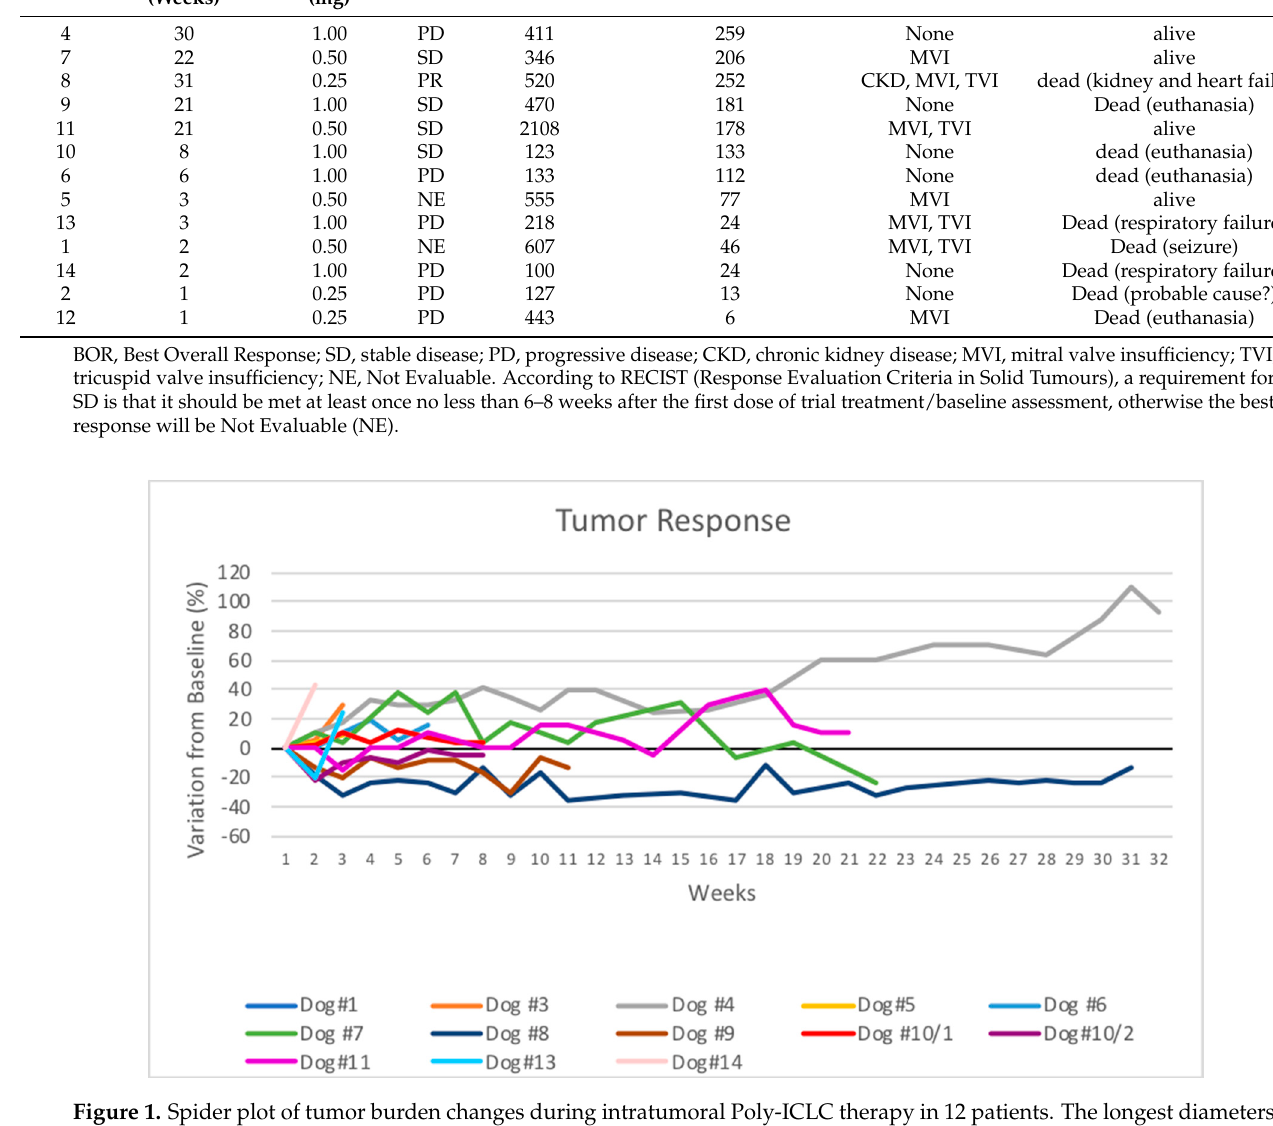
Figure 1. Spider plot of tumor burden changes during intratumoral Poly-ICLC therapy in 12 patients. The longest diameters of the injected lesions are demonstrated as changes from baseline of one lesion from each dog, except from Dog #10 that had two lesions injected with Poly-ICLC.